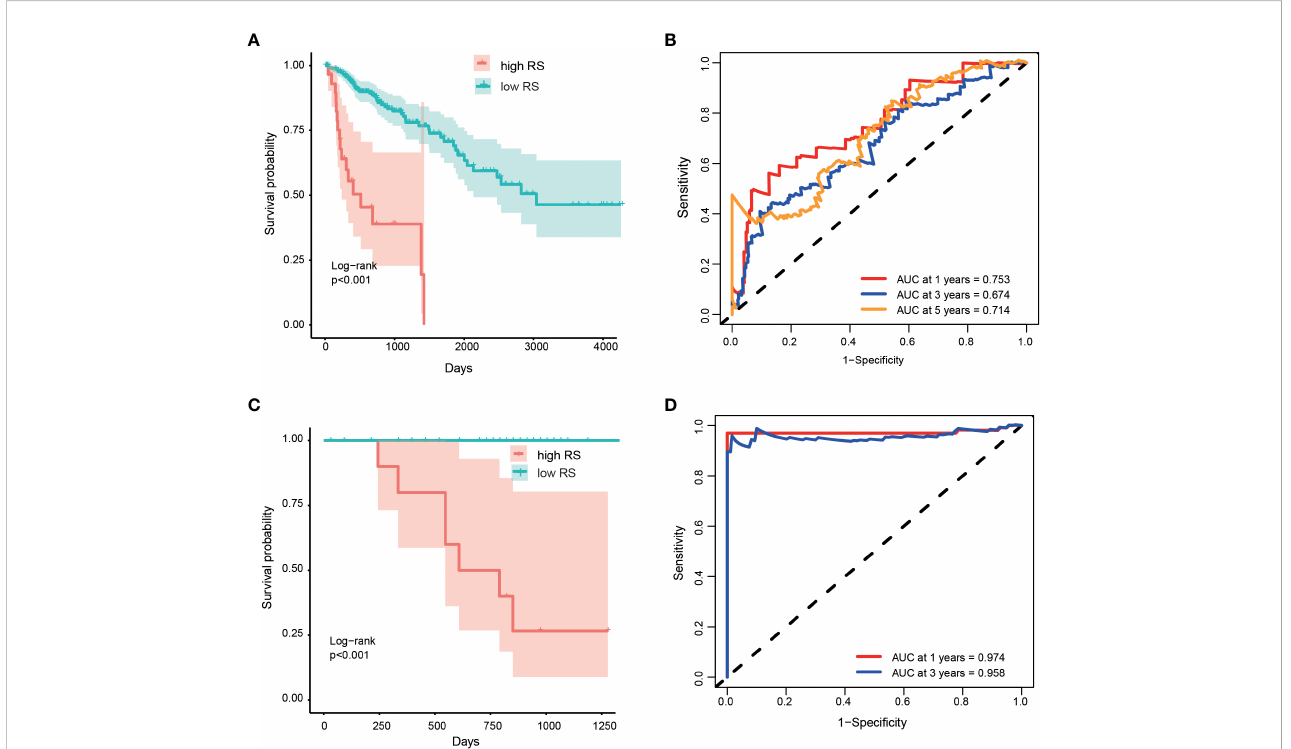
FIGURE 3 Performance of prognostic risk model in discovery and validation cohort. Kaplan-Meier curves shown the overall survive among patients classi fi ed into high- and low- RS groups in discovery (A) and validation (C) cohorts. The difference of survival time between the two groups was tested by log rank method. ROC curves and their AUC value shown the performance of the prognostic risk model in predicting the one, three and fi ve years survive time in discovery (B) and validation (D)